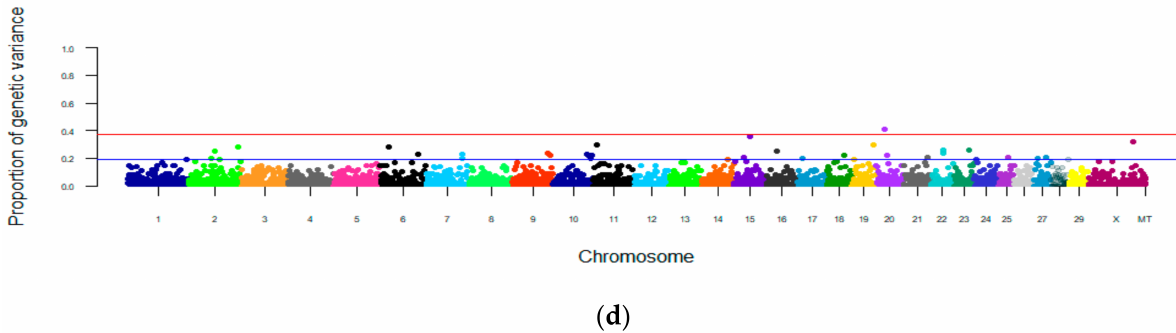
Figure 2. Manhattan plot showing genome-wide association window variance for fat percentage ( a ), crude protein percentage ( b ), milk urea concentration ( c ), and efficiency of crude protein utilization ( d ). The red line shows the genome- wide significant level at PVE = 0.37% and the blue line shows the suggestive association significant level at PVE = 0.19%.